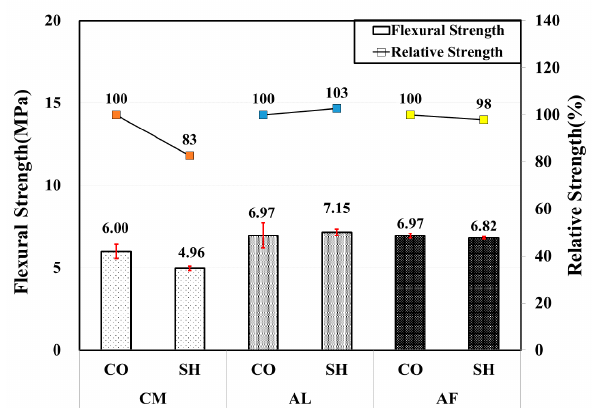
Figure 11. Flexural strength by accelerators for 12-month-old specimens.